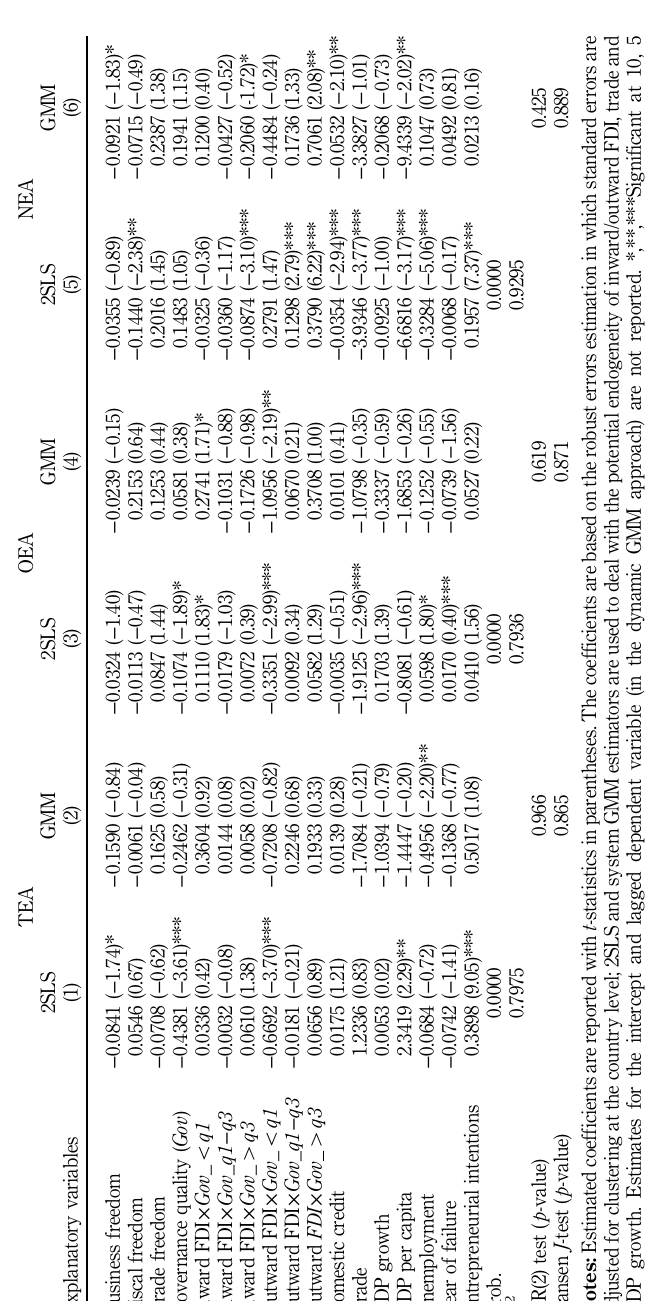
Table AII. Governance quality, FDI and entrepreneurship: 2SLS and GMM